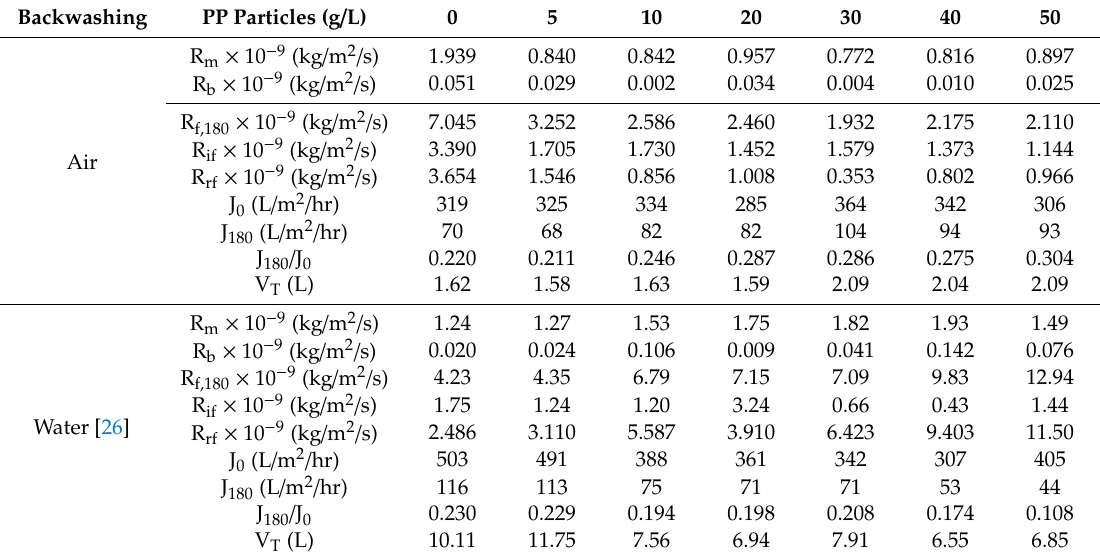
Table 9. Influence of pure PP particles concentration on separation elements in the integrated system, of multichannel ceramic MF and pure PP particles, using air backwashing (FT 10 min, BT 10 s); paralleled with the consequences of water